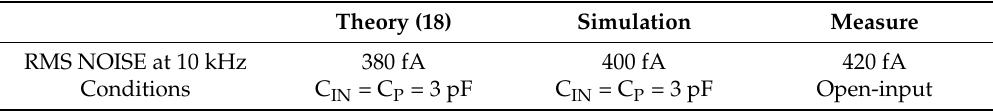
Figure 12. ( a ) Open-input input-referred noise measured at two different ranges (20 nA and 200 pA). ‘ The noise is as low as 4 fA/ Hz in the best condition ( i.e. , range = 200 pA and digital filtering at ‘ 10 kHz with a sinc 3 LPF), while raises to 6 fA/ Hz at 200 pA range and digital filtering at 200 kHz. ‘ The highest noise floor, that is 40 fA/ Hz, is shown in the wider 20 nA range. Digital FIR filters with triangular windowing and 150 taps were used; ( b ) Short-time trace recorded at bandwidth = 175 kHz showing periodic spikes every T R = 102.4 µ s. This spikes are linked to the period reset activity; ( c ) Relation between input-referred r.m.s. noise at 10 kHz and input capacitance C in , which takes into care microfluidic device together with BLM. Measured values are compared with simulations and theoretical estimation, validating Equation (19). Table 2. Comparison of noise theory with simulation and